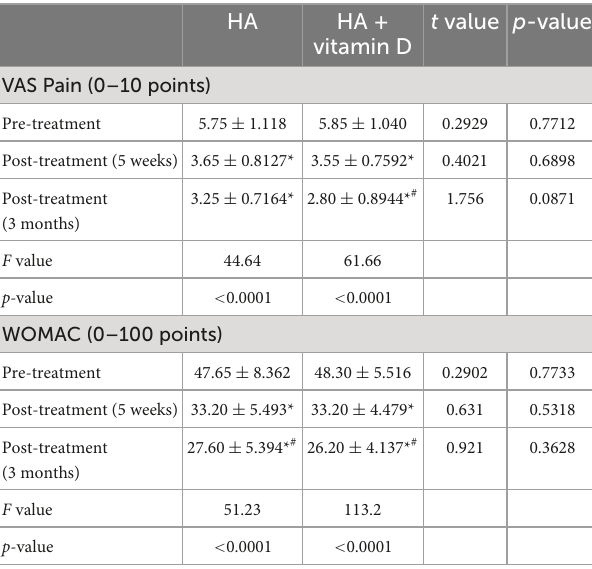
TABLE 6 Effect of HA injection with or without vitamin D supplementation on VAS and WOMAC Scores.